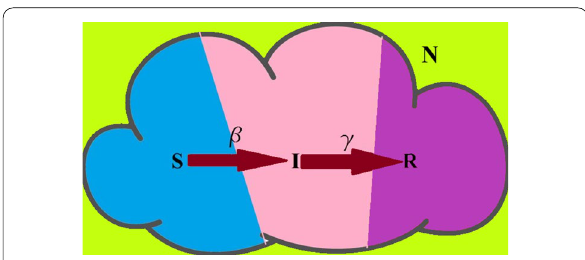
Fig. 3 Scheme of the fraction of the SIR